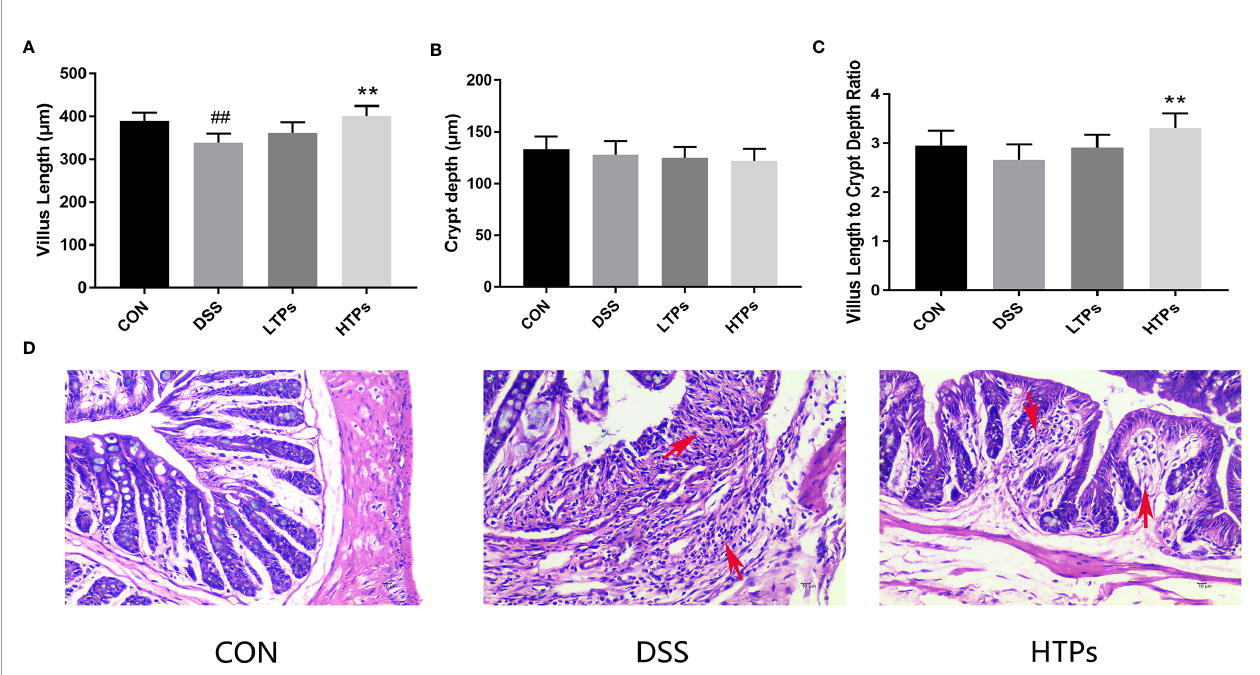
FIGURE 3 | Effects of HTPs on colonic morphology in DSS-challenged mice. (A) Villus height. (B) Crypt depth. (C) Villus length to crypt depth ratio (VCR). (D) Representative images of H & E staining of the colon tissue (magni fi cation 400×). CON, control group; DSS, DSS challenge group; LTPs, DSS challenge + 200 mg/kg TPs; HTPs, DSS challenge +300 mg/kg TPs. All values are represented as mean ± SD ( n = 6). ## p < 0.01 v . normal group. ** p < 0.01 v . control